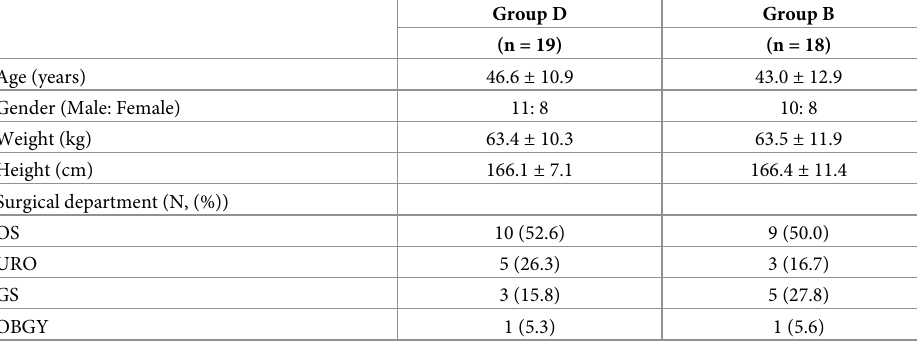
Group D Group B